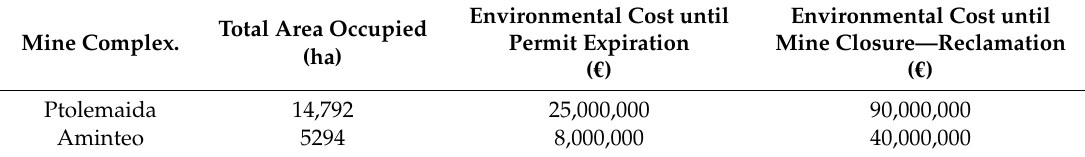
Table 1. Cost of implementing the terms and conditions of environmental permits [19].